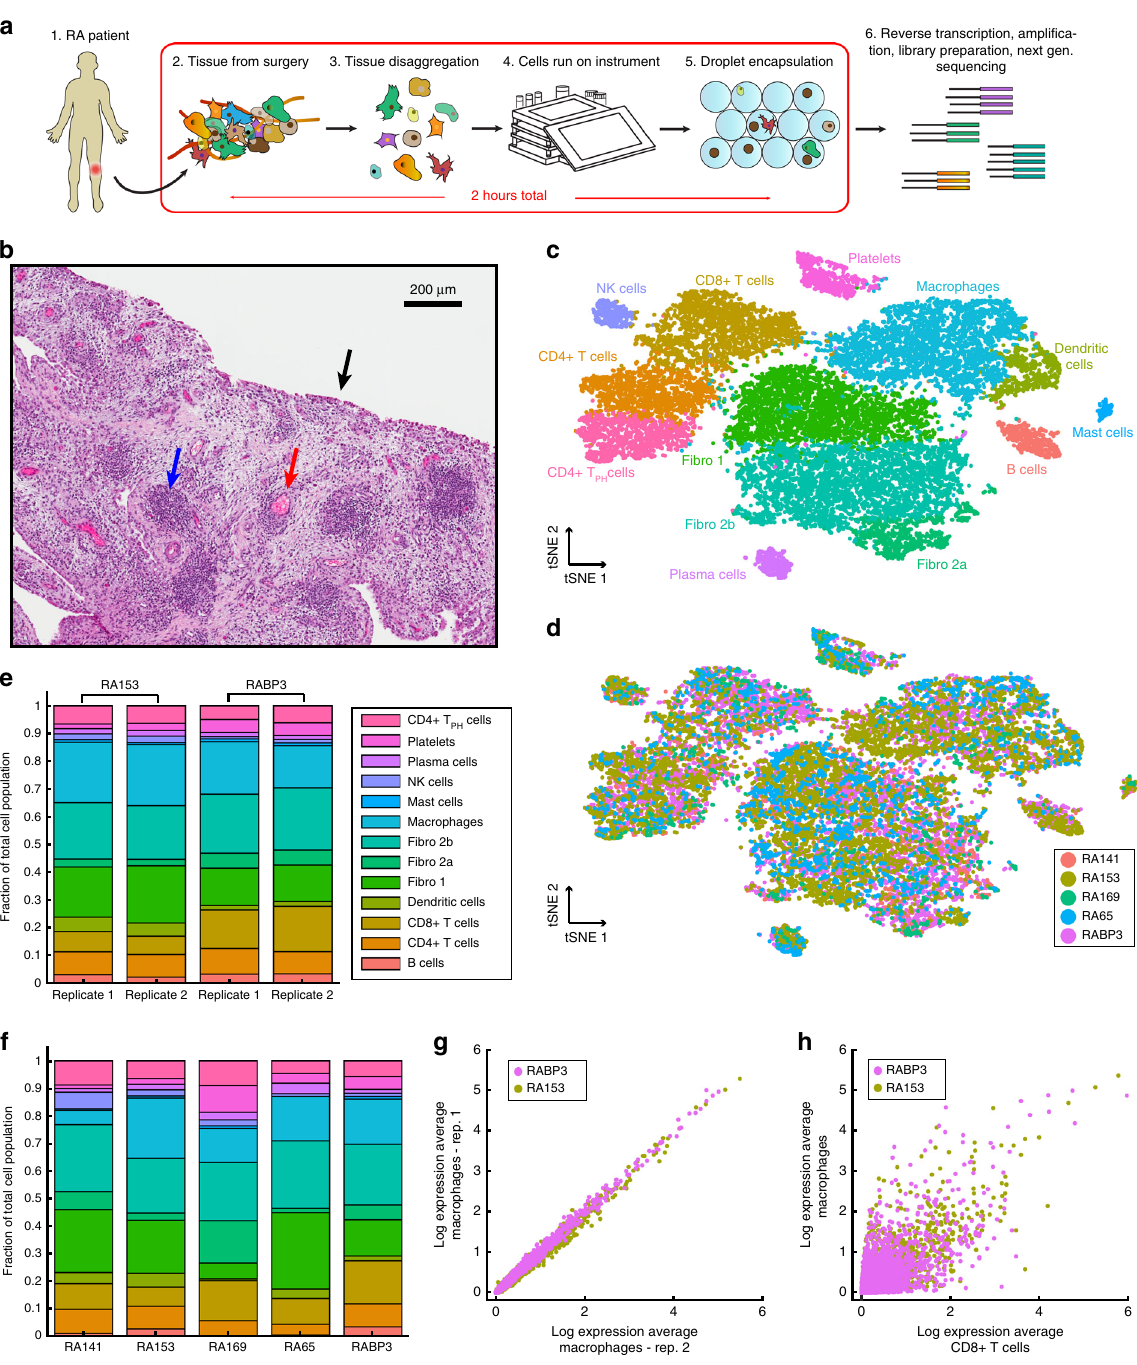
cellsLog expression average Log expression average macrophages - rep. CD8+ T Fig. 2 RA single-cell unsupervised clustering and analysis. a Sample work fl ow from operating room to sequencing. Preparation of single cells into droplets with barcoded microparticles is performed in about 2 h. b H&E stain of synovial tissue from patient tissue. The synovial lining is indicated by the black arrow. An example of vasculature is indicated by a red arrow. The blue arrow denotes a dense lymphocyte in fi ltrate. c Unsupervised graph-based clustering of single-cell RNA-seq, visualized using t-distributed stochastic neighbor embedding (tSNE). Each point represents a single cell (droplet barcode). d Graph- based clustering of single-cell RNA-seq, visualized using tSNE colored by patient sample. e Fraction of total cells present in each cluster across two patients (RA153 and RABP3) in replicate. f Fraction of total cells present in each cluster, for each patient. Color legend is as in e . g Bulk expression ( ‘ in silico average ’ ) comparisons across macrophages from each replicate for patients RA153 and RABP3. h Expression comparison across combined CD8+ T cell